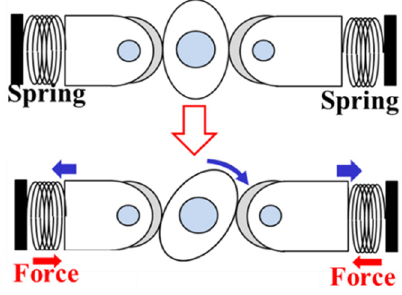
Figure 5. Normal-close mechanism.